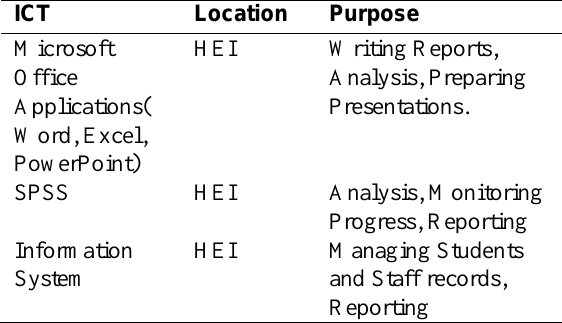
Table 9. Utilized Software in HEIs ICT Location Purpose